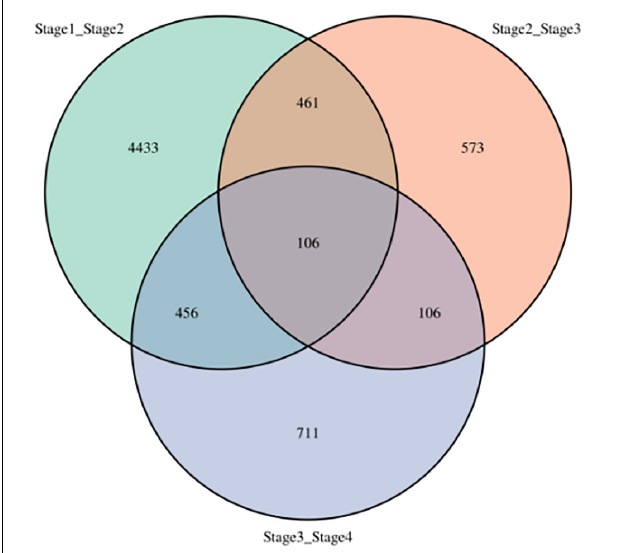
FIGURE 3 | Differentially expressed genes at four development stages in sorghum. stage1_stage2: stages 1 and 2, stage2_stage3: stages 2 and 3, stage3_stage4: stages 3 and